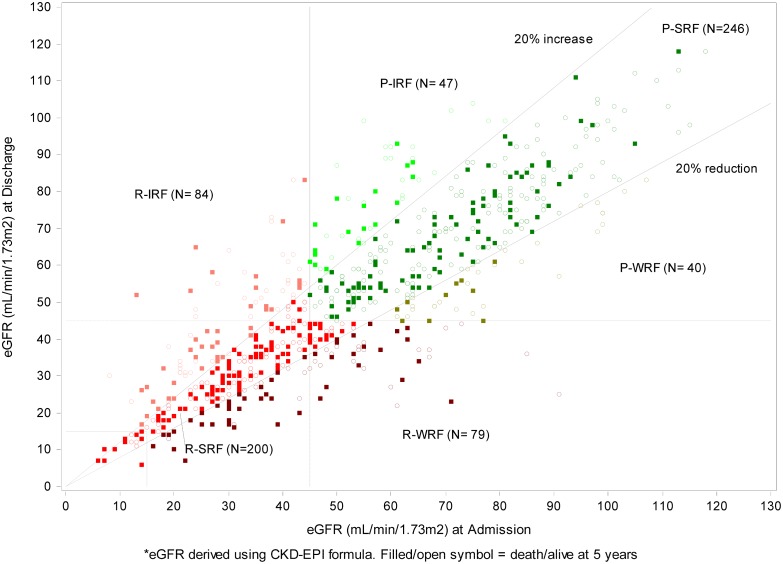
Scatter plot of admission versus discharge eGFR.